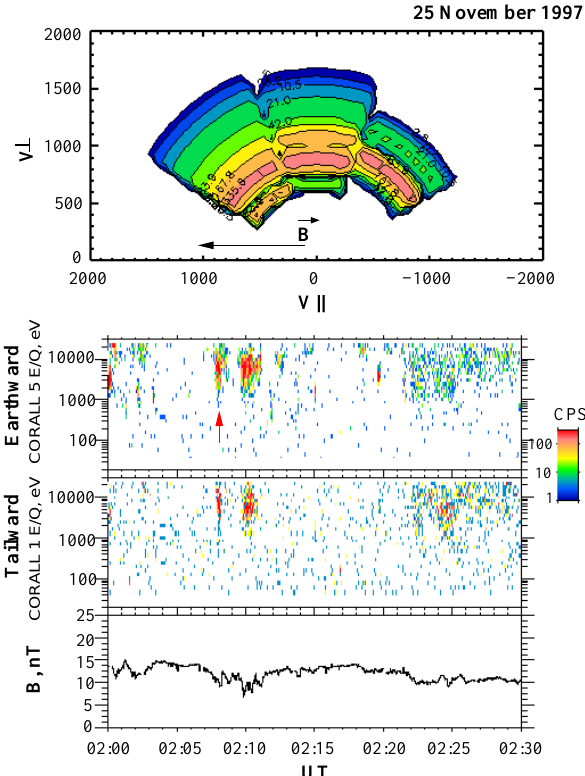
Fig. 4. The same as Fig. 2 showing a bidirectional ion beam obser-